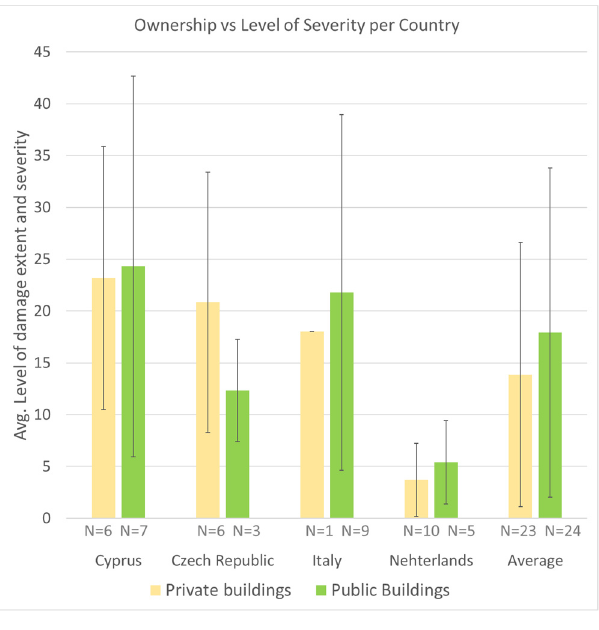
Figure 11. Level of damage severity vs. type of ownership per country.